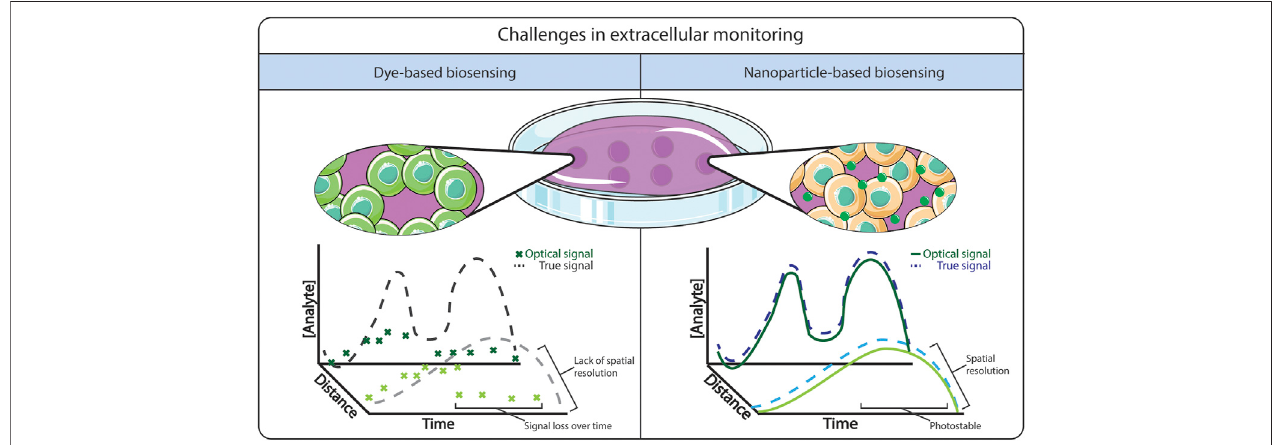
FIGURE 1 | Comparison between free dye-based biosensing versus nanoparticle-based biosensing. The advantages of using nanoparticle-based biosensing is a stable signal from the dye, where it is less prone to photobleaching and dye leaching.